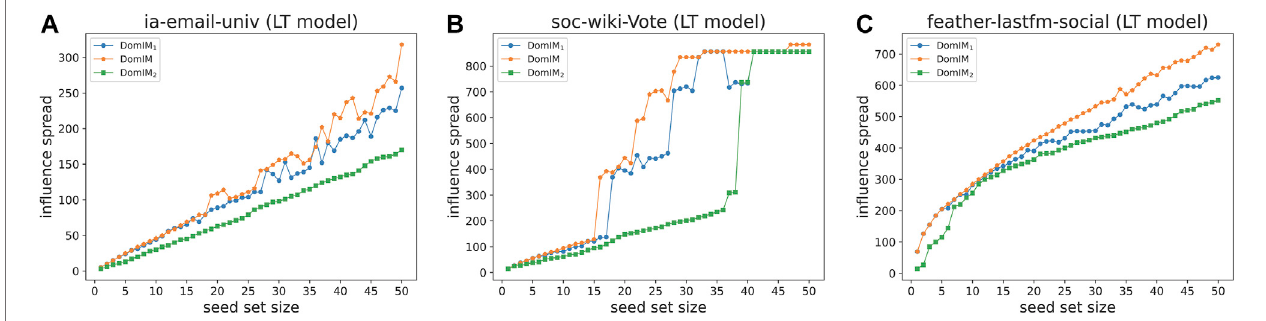
FIGURE 4 | Comparison results between DomIM and its alternatives under LC model.